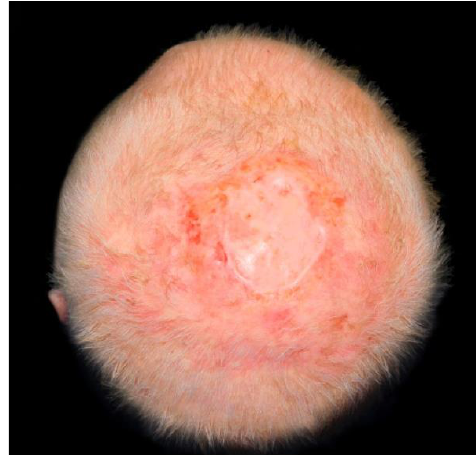
Figure 2. Final scar result at 12 months follow-up.